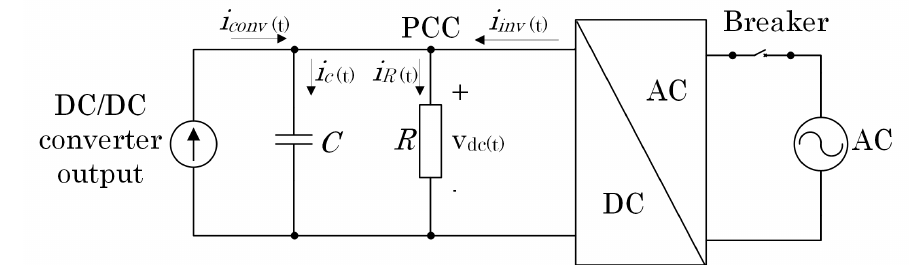
Figure 8. Equivalent circuit in normal and islanding